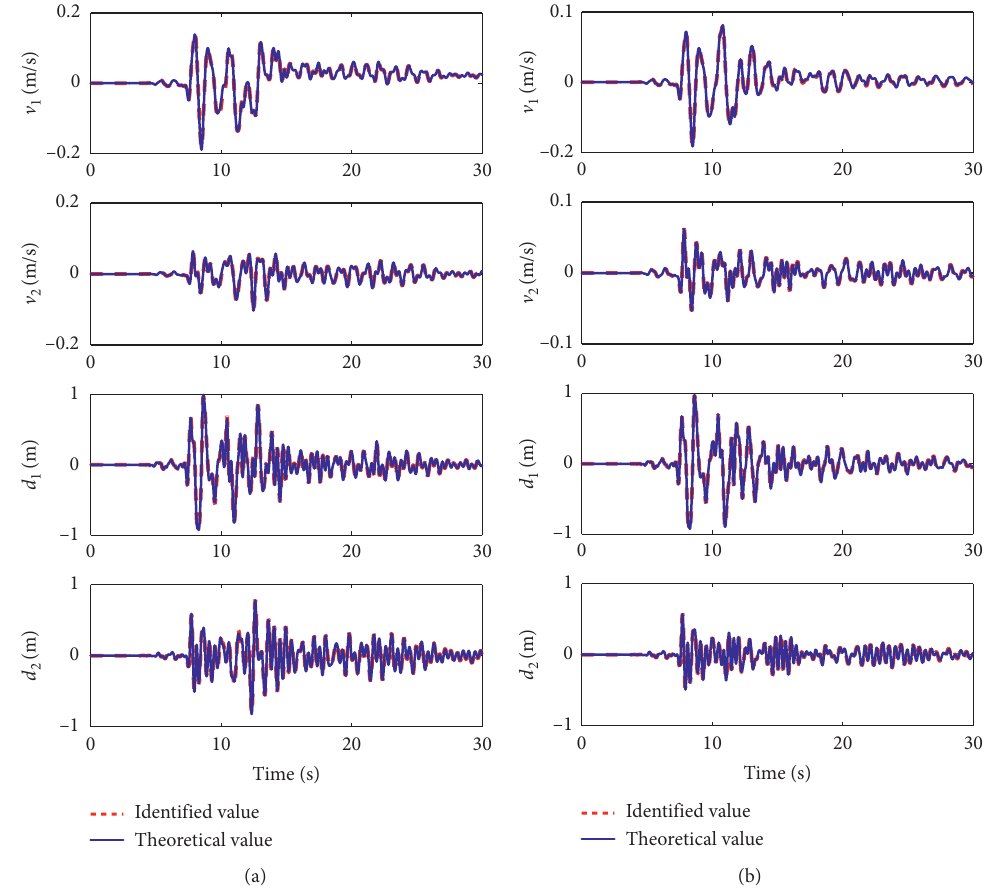
Figure 22: Comparison of velocities and displacements under Kobe earthquake wave. (a) Case 1. (b) Case